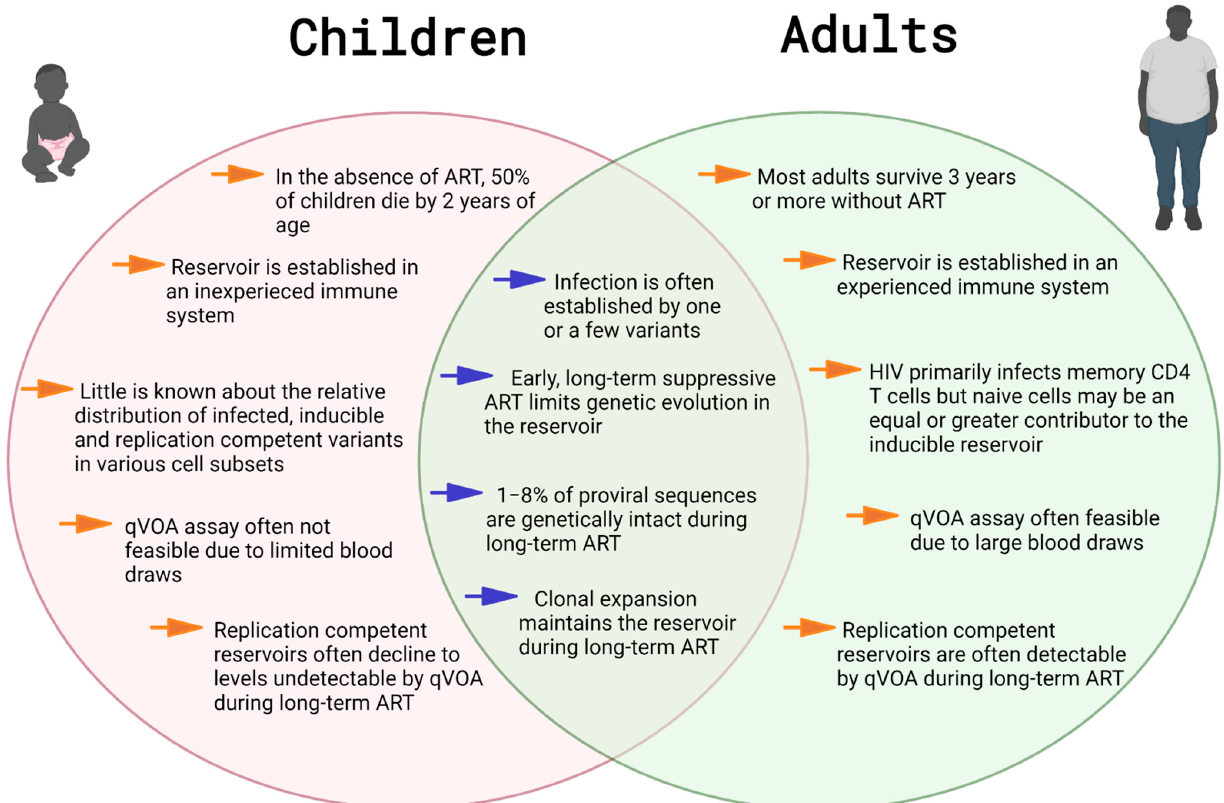
Figure 2. HIV-1 persistence in children vs. adults.